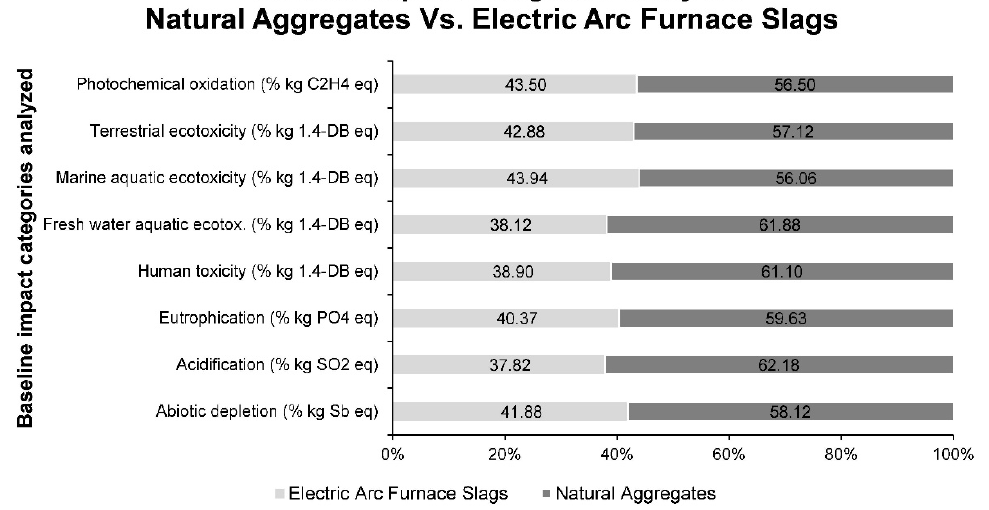
Figure 6. Percentages of emissions from various impacts for natural siliceous aggregates and electric arc furnace slags.